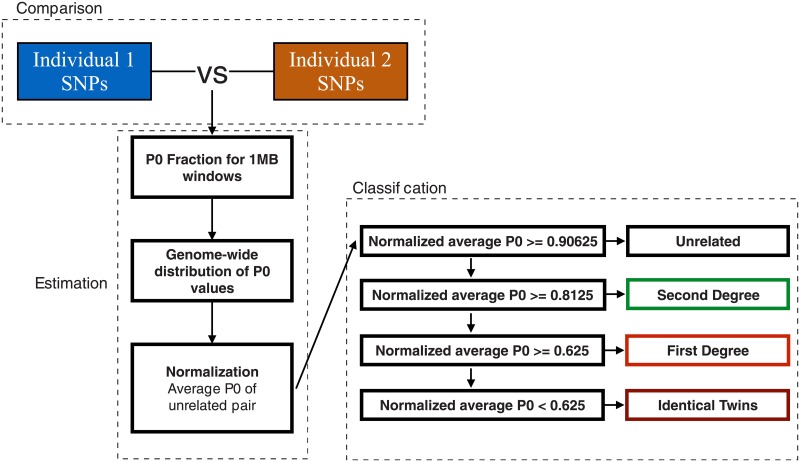
Outline of the general READ workflow to estimate the degree of relationship between two individuals.